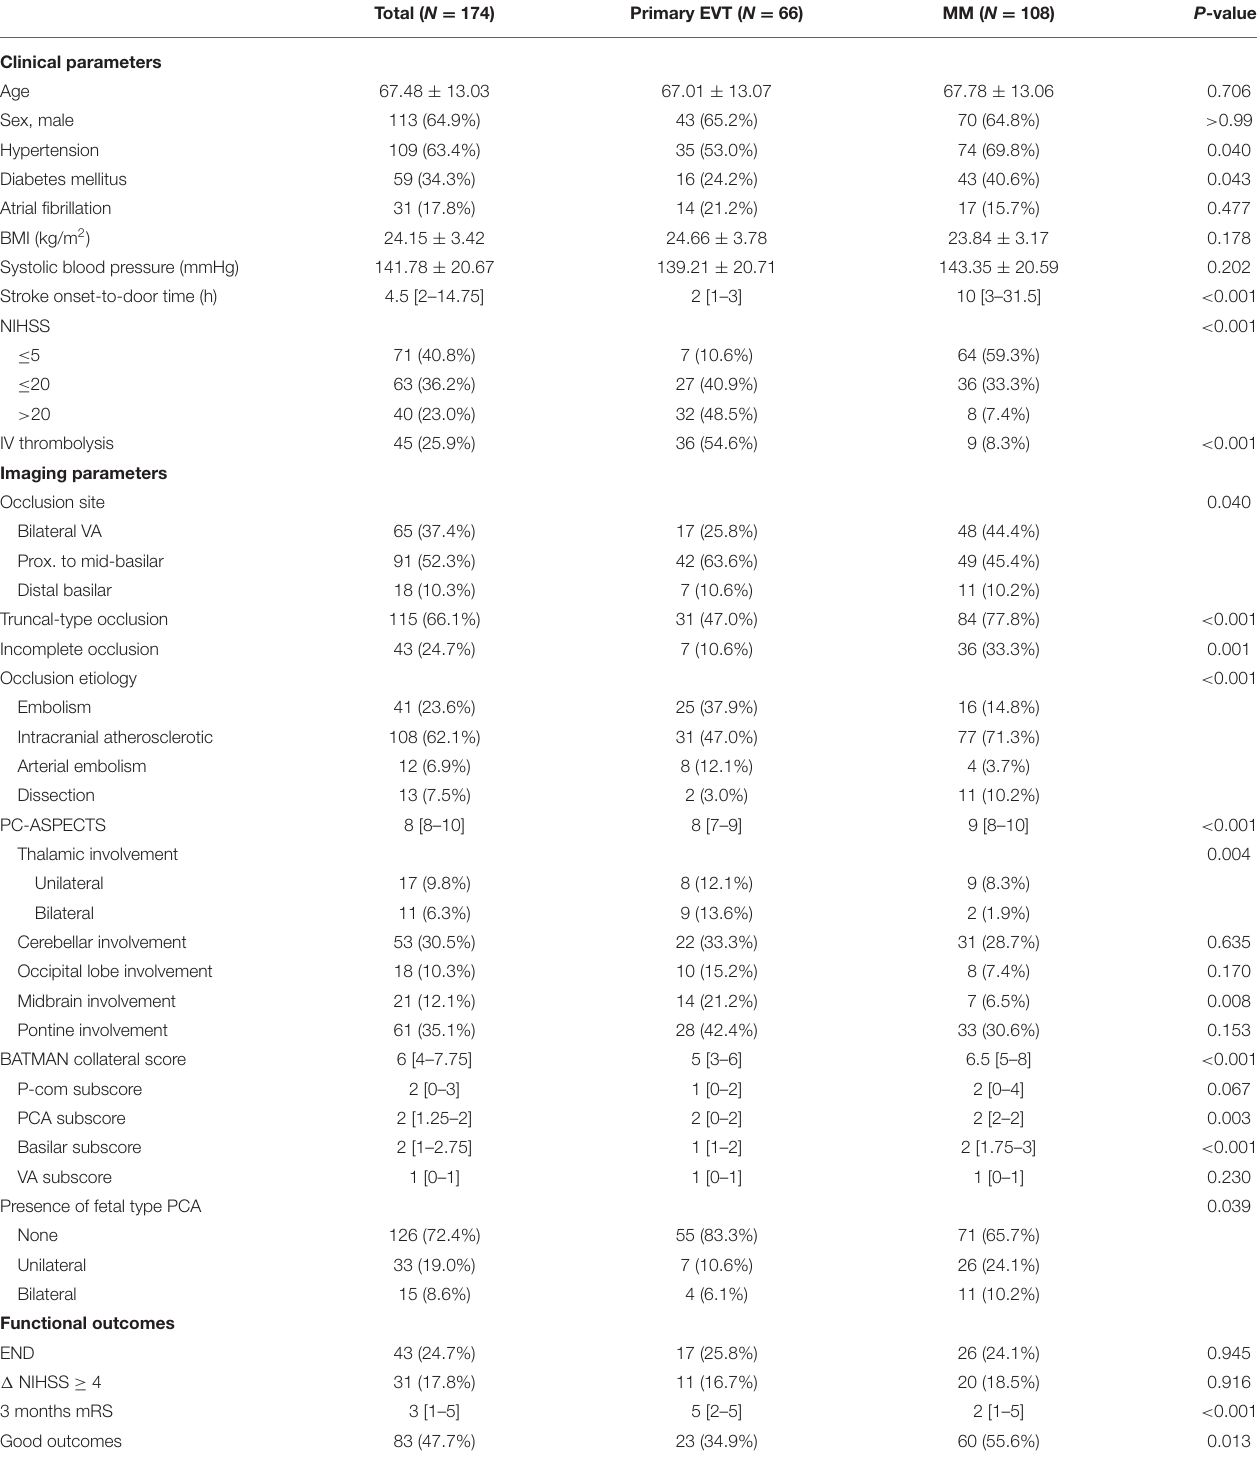
TABLE 1 | General characteristics of patients in the primary EVT group and MM group.